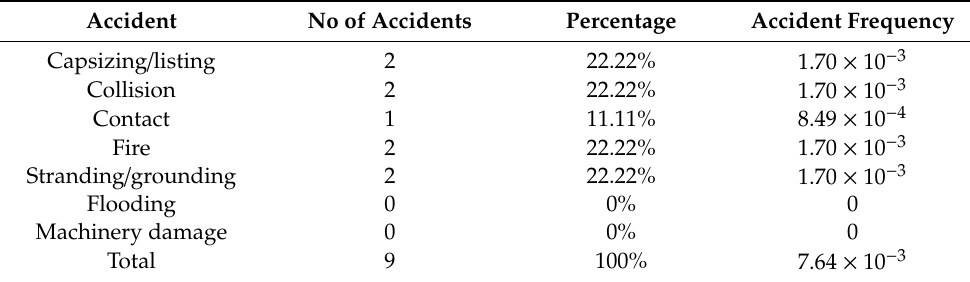
Table 14. Number of incidents and frequencies for inland waterways